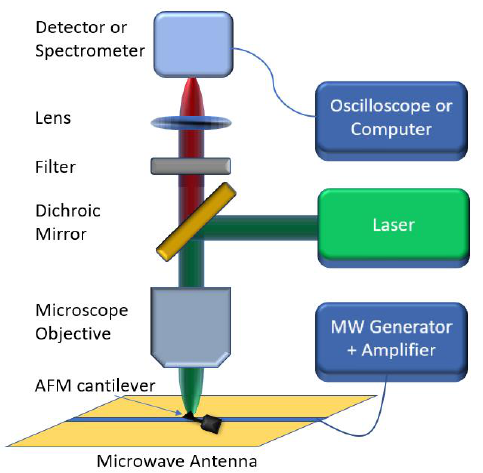
Figure 2. Schematic of the fluorescence and ODMR measurement setup.